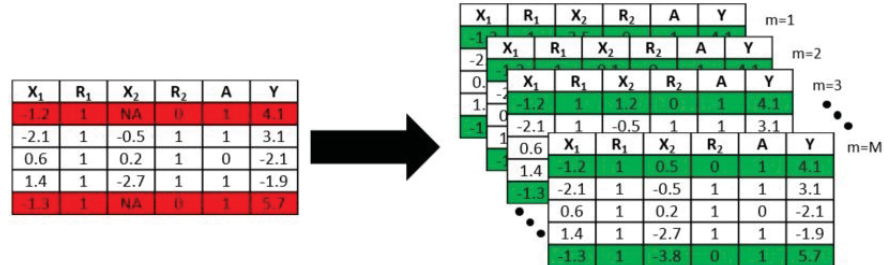
Figure 1: Imputed Data via